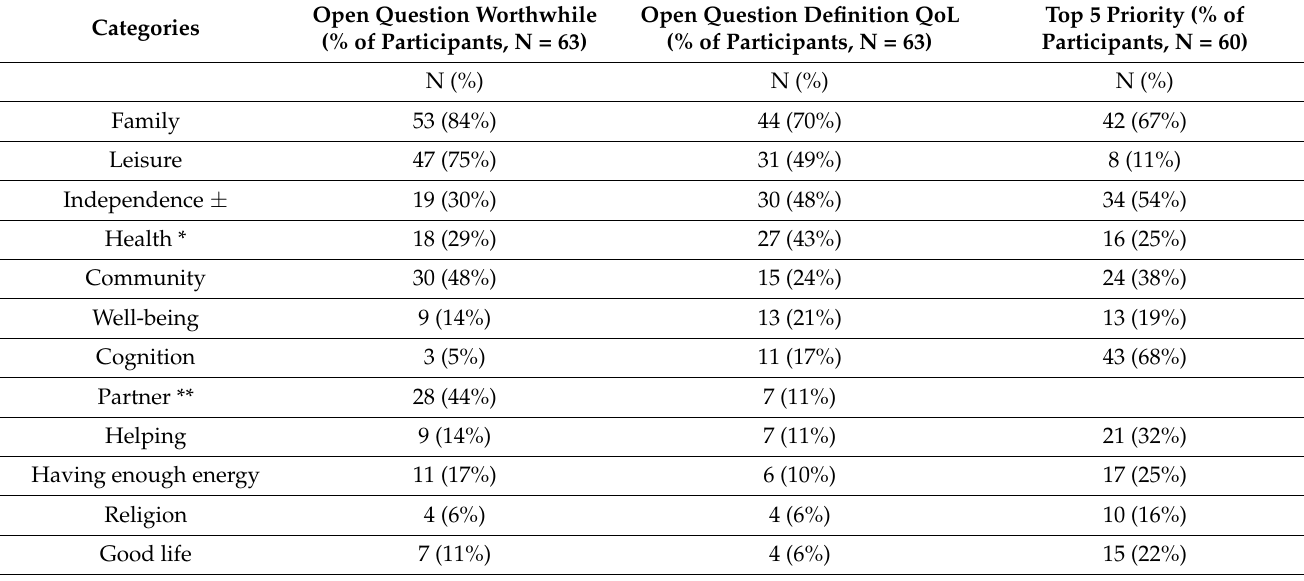
Table A2. Answers Allocated to